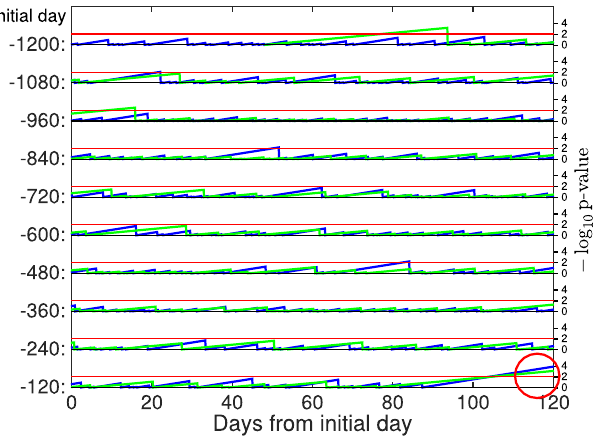
Figure 7. Evolution of p-values of inter-event time for class S1 (blue) and V1 (green), respectively. The horizontal axis denotes time (day) and the vertical axis negative logarithm of p-values with base 10. Here, time is evaluated as days from the Tohoku-oki EQ. Since volcanic tremors of class V1 are observed only after − 1152 days, we consider the time span from − 1200 days to 0 from the Tohoku-oki EQ, which is split into 10 sub-time spans. Each row in the plot denotes a particular sub-time span in which the initial day is shown at the left. P-values are evaluated using parameters in a fitted exponential distributions as detailed in the caption of Fig. 6, discarding inter-event times smaller than the cutoff inter-time that defines S1 and V1, respectively. The horizontal red line denotes the significance level 0.01 (the corresponding negative logarithm is 2). P-values of both class S1 and class V1 take four just before the Tohoku-oki EQ (red